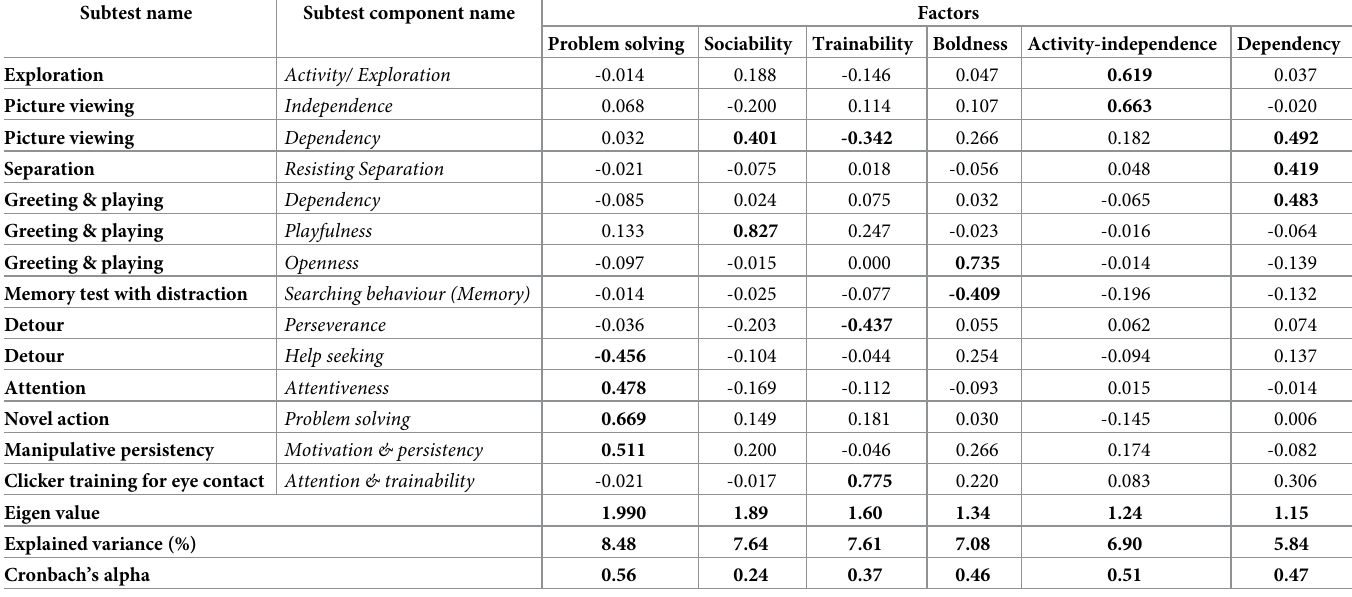
Table 13. Results of the exploratory factor analysis